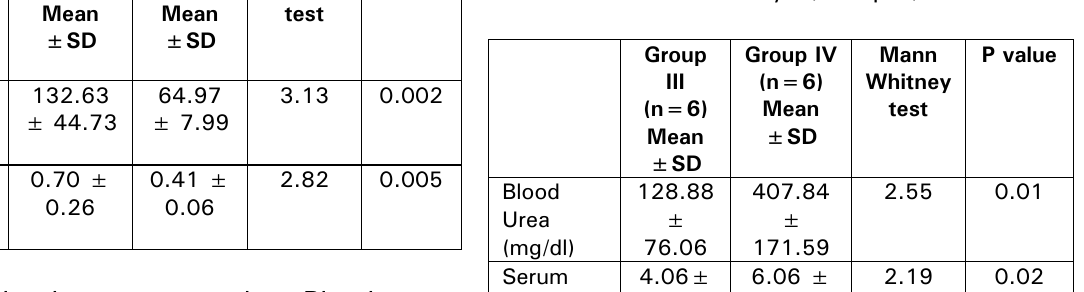
Table3: comparison between day5 renal functions between cisplatin induced AKI rats that were treated with lithium chloride in day 3(GroupIII) and were treated with saline in day3 (GroupIV)